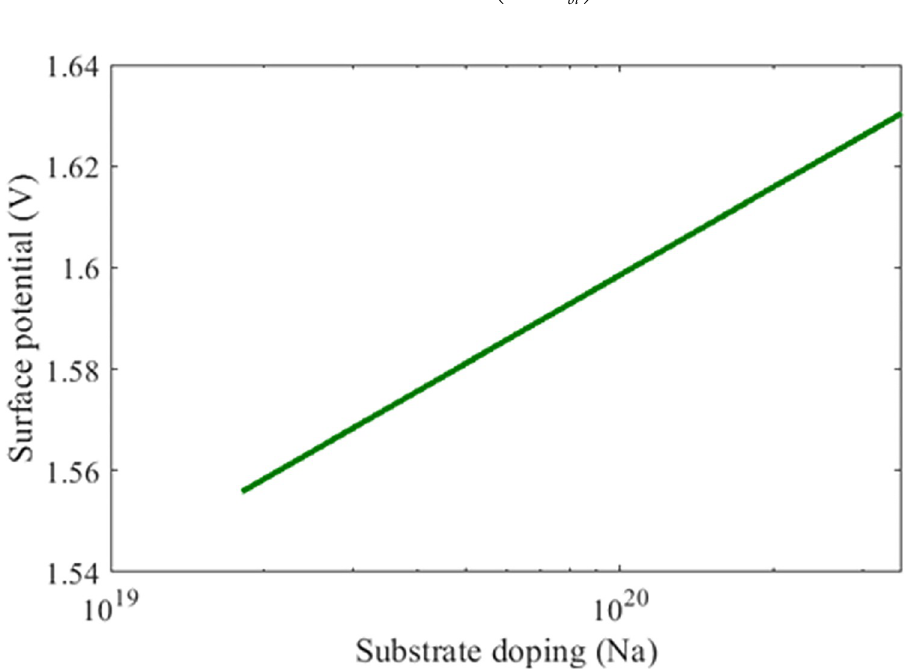
Fig 3. Sic nmos surface potential as a function of substrate